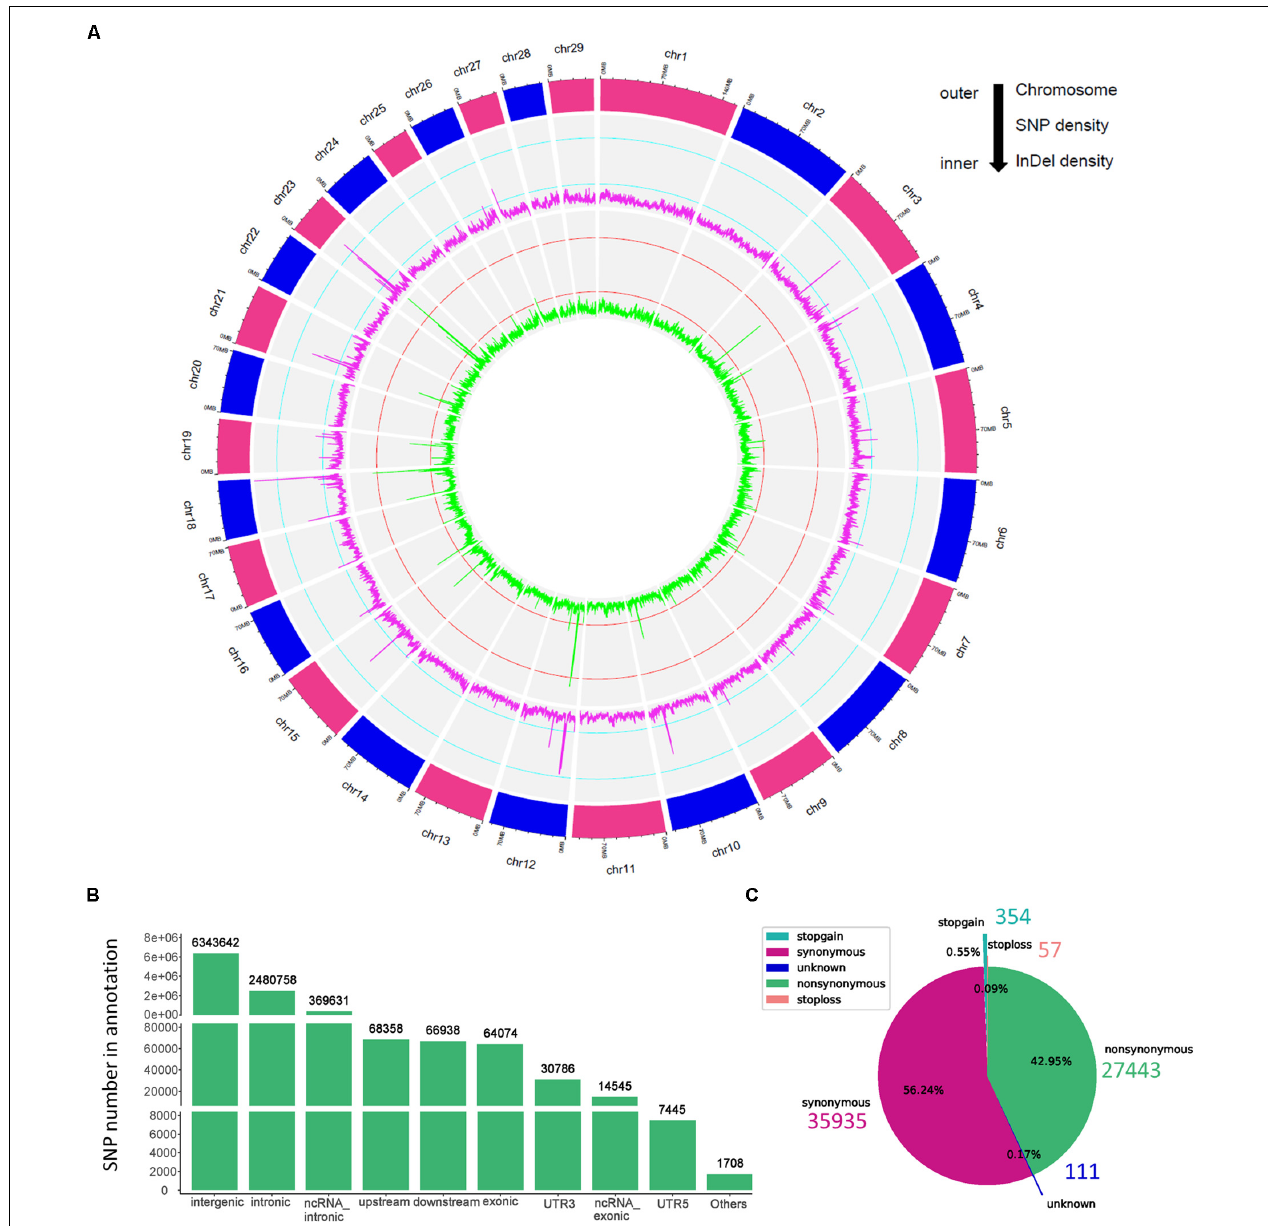
FIGURE 1 | The genomic variants identified and annotated in Jining Gray goat. (A) Circos plot of variants density after filtration. The density of variants was calculated in each 100 kb step size. From outer to inner, the outermost circos depicts each chromosome, the middle displayed the SNP density per window (magenta), and the internal circos meant the indel density per window (green). The cyan and red lines in secondary and third cycle was indicated the 0.25 and 0.75 stack height, respectively. (B) Genomic annotation of SNPs according to ANNOVAR. “Others” contained a few other categories of “upstream; downstream,” “splicing,” “ncRNA_splicing,” “exonic; splicing,” “UTR5; UTR3,” and “ncRNA_exonic; splicing.” (C) The pie plot of annotated SNPs at exonic regions.